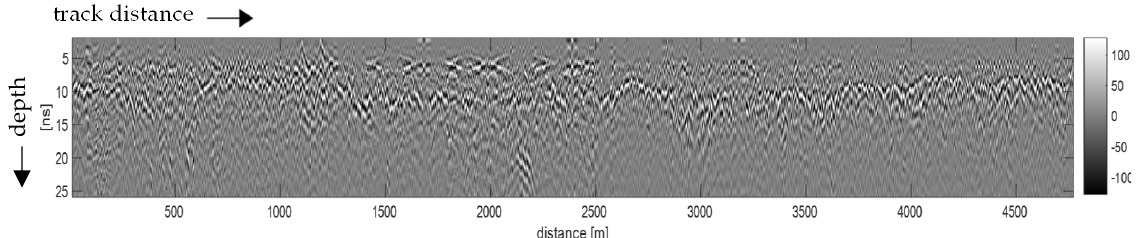
Figure 1. ( a ) Three GPR transducers mounted on a rail vehicle (indicated by the white ellipse), ( b ) principle of signal generation: typical subsurface structure of a railway track, and ( c ) the corresponding reflected radar signal amplitudes (A–scan or trace), which typically occur strongly at well–defined layer boundaries with different dielectric properties.